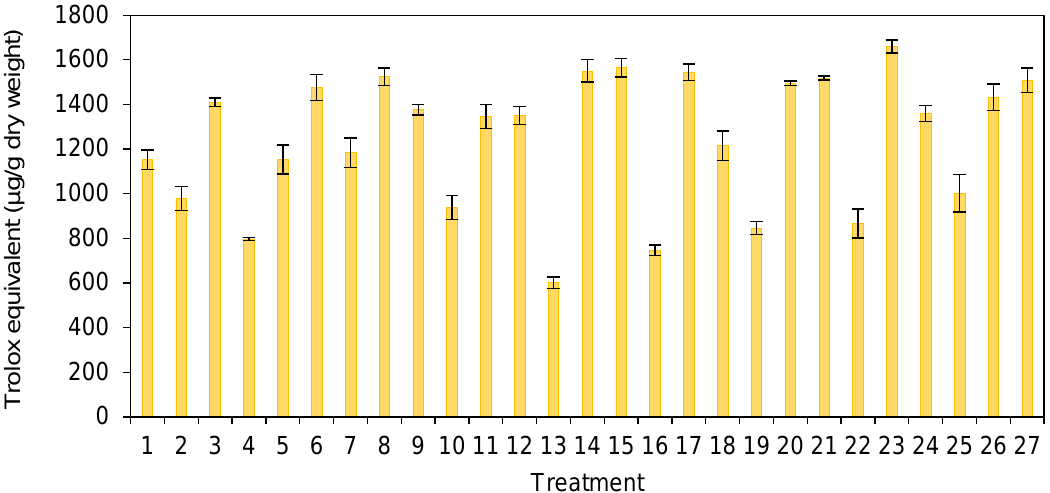
Figure 2. The Trolox equivalent in the H. erinaceus extracts from different pretreatment processes (Error bars represent a standard deviation of three replicates).